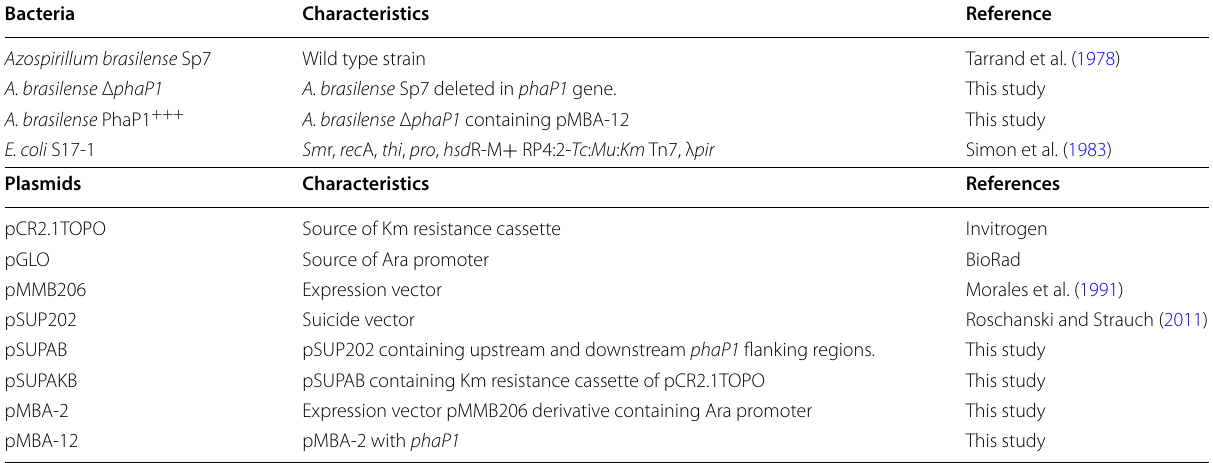
Table 1 Strains and plasmids used in this